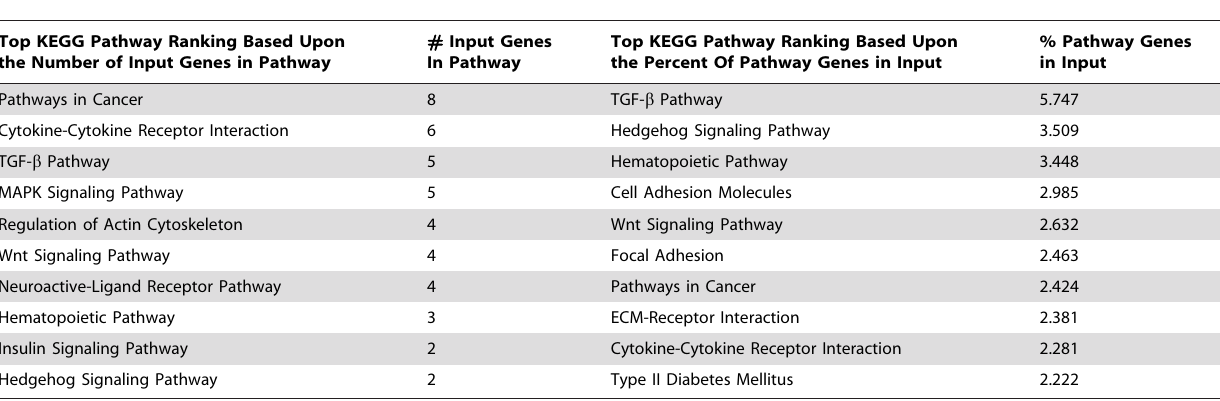
Table 1. Hierarchy of KEGG pathway assignments of genes significantly changed by 2-fold or greater in WPMY-AR cells treated with